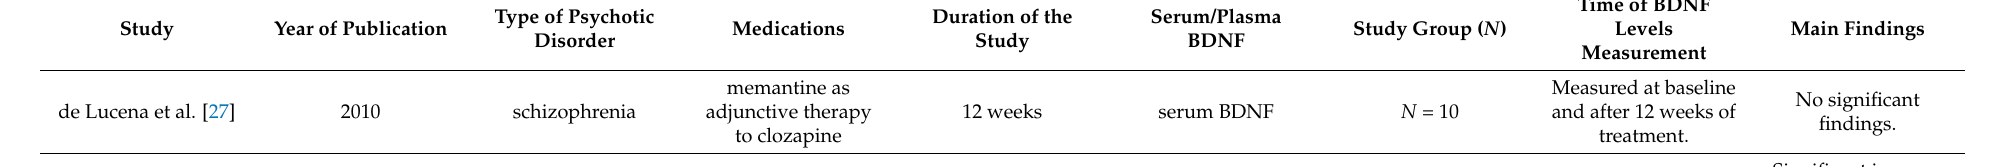
Table 1. The influence of antipsychotic treatment on